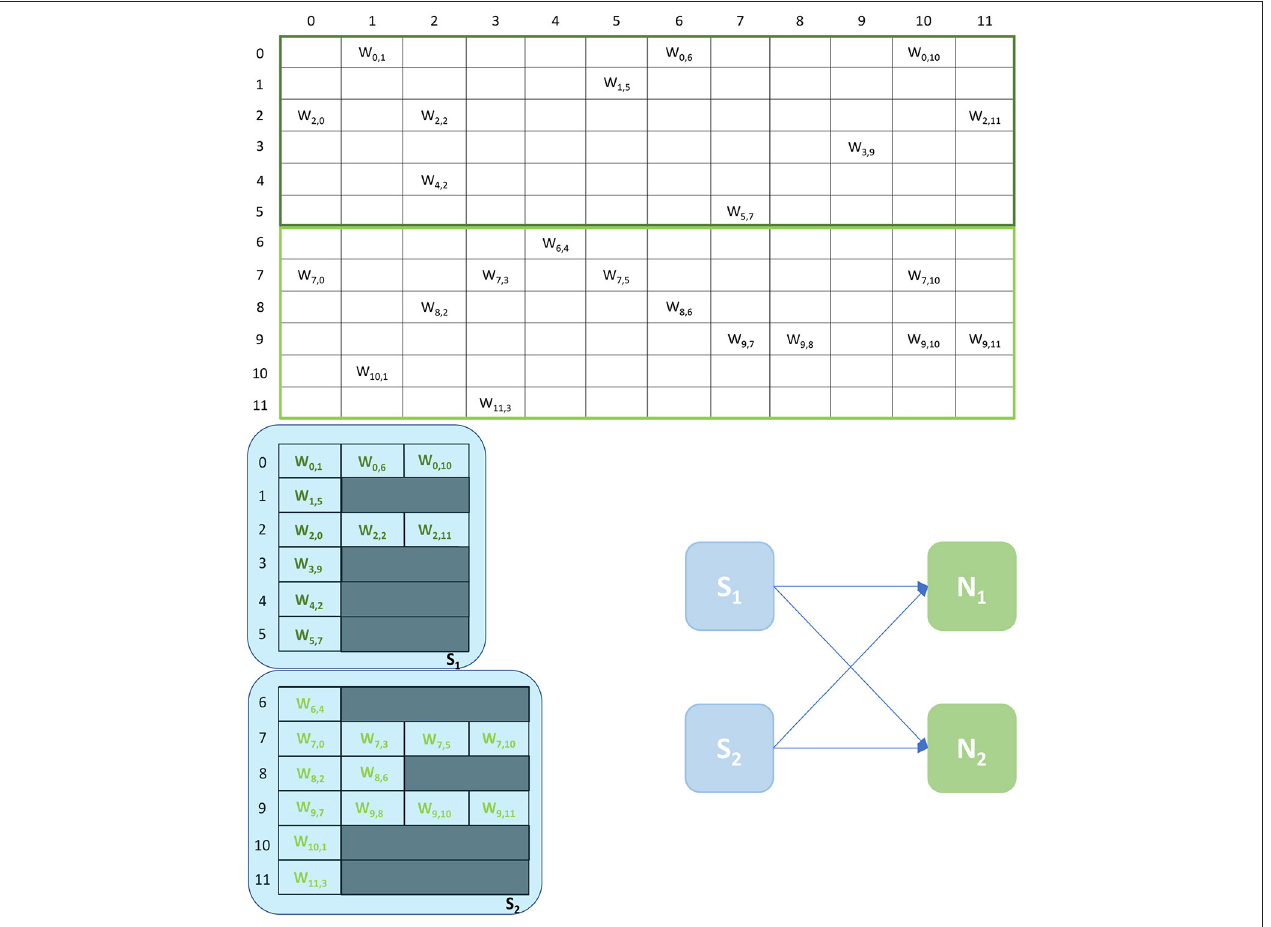
FIGURE 5 | Synaptic matrix partitioning for the Multi-target approach. The used network is the same shown in Figures 2 , 3 . Here, Synapse cores have much longer synaptic rows, further reducing the risk of empty rows, therefore fewer resources are required. The generated ensemble is shown on the